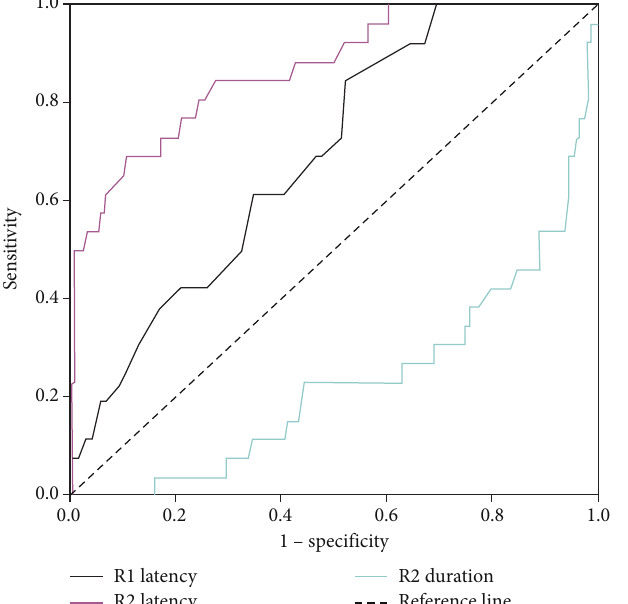
Figure 1: Graph ROC curves showing AUCs of di ff erent BR parameters for the diagnosis of dizziness. Abbreviations: AUC: area under the curve; ROC: receiver operating characteristic.